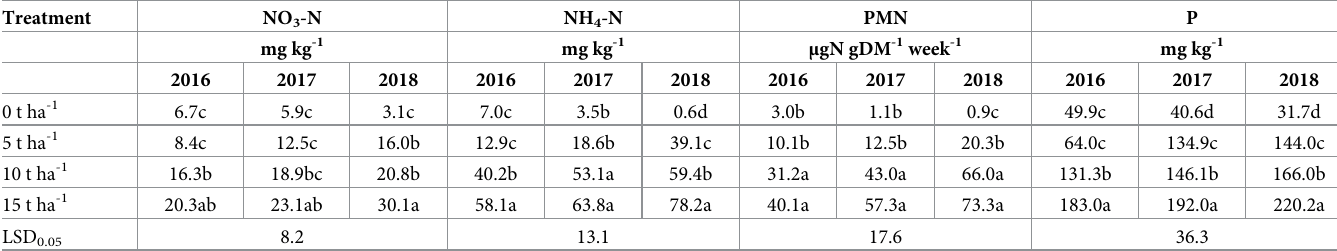
Table 10. Soil NO 3 -N, NH 4 -N, PMN and P as influenced by compost application rates over a three year (2016–2018) study at the Politsi orchard. Treatment